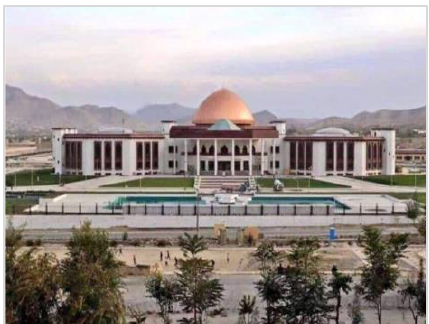
Figure 14 New parliament building designed with mixed western and Islamic architectural styles in Kabul city (AAN,